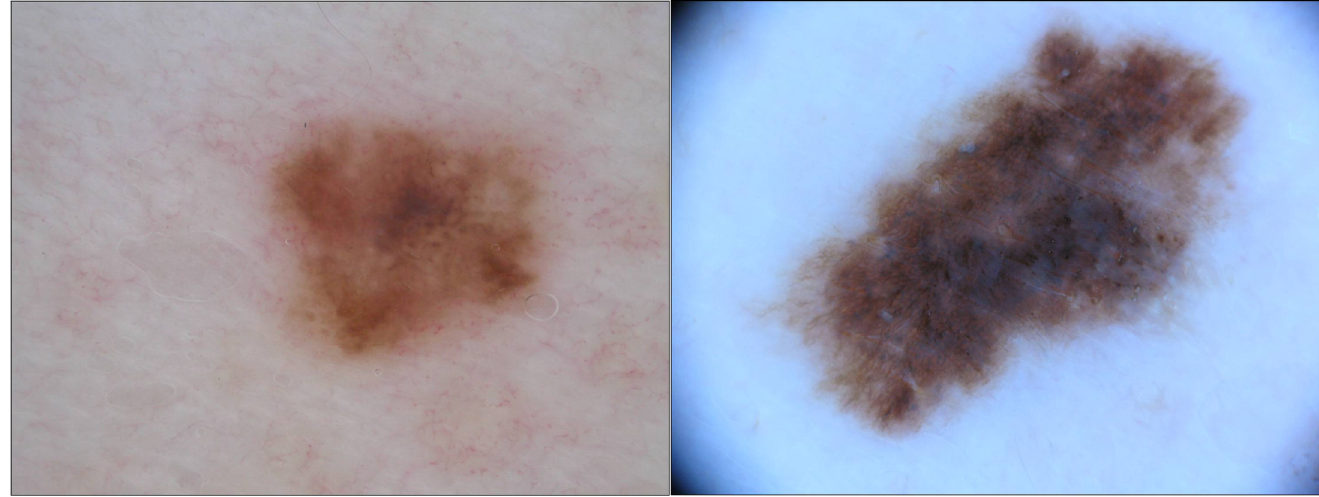
Fig 3. Different colour. Exampleof different colour calibration and/or different light source from the ISIC Data Archive. Image ISIC_0000023 and ISIC_0000037 of the ISIC Archive, sharedunder the CC-0 license.